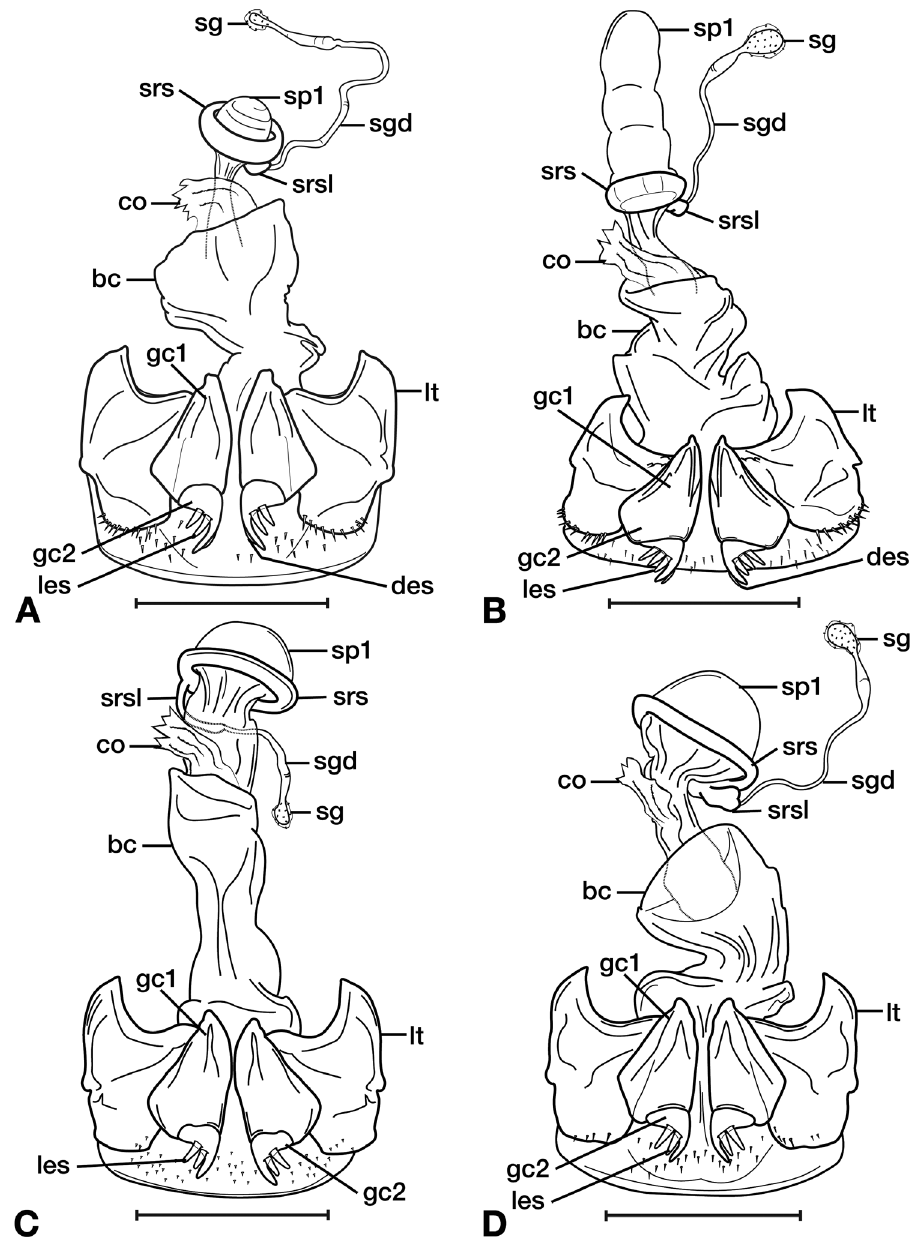
Figure 71. Line drawings of the female reproductive tract of species of the genus Dolichoctis (Schmidt- Goebel) known from Taiwan, ventral aspect. A D. badiadorsis sp. n. B D. dilatata sp. n. C D. rotundata (Schmidt-Goebel) D D. taiwanensis Baehr. Legend: bc bursa copulatrix; co common oviduct; des dorsal ensiform setae gc1 gonocoxite 1; gc2 gonocoxite 2; les lateral ensiform setae; lt lateral tergite; sg sper- mathecal gland; sgd spermathecal gland duct; sp1 spermatheca 1; srs spermathecal ring sclerite; srsl spermathecal ring sclerite lobe. Scale bars: 0.5